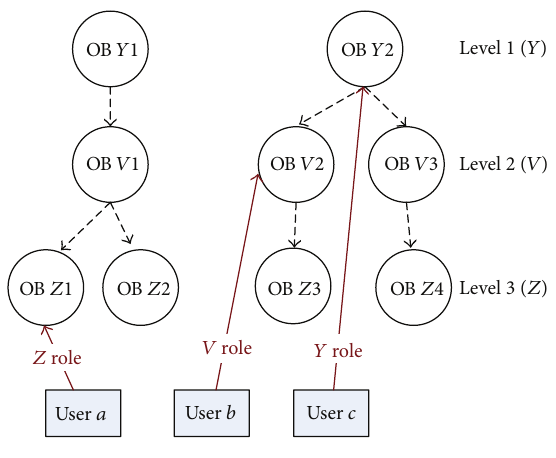
Figure 4: The concept of